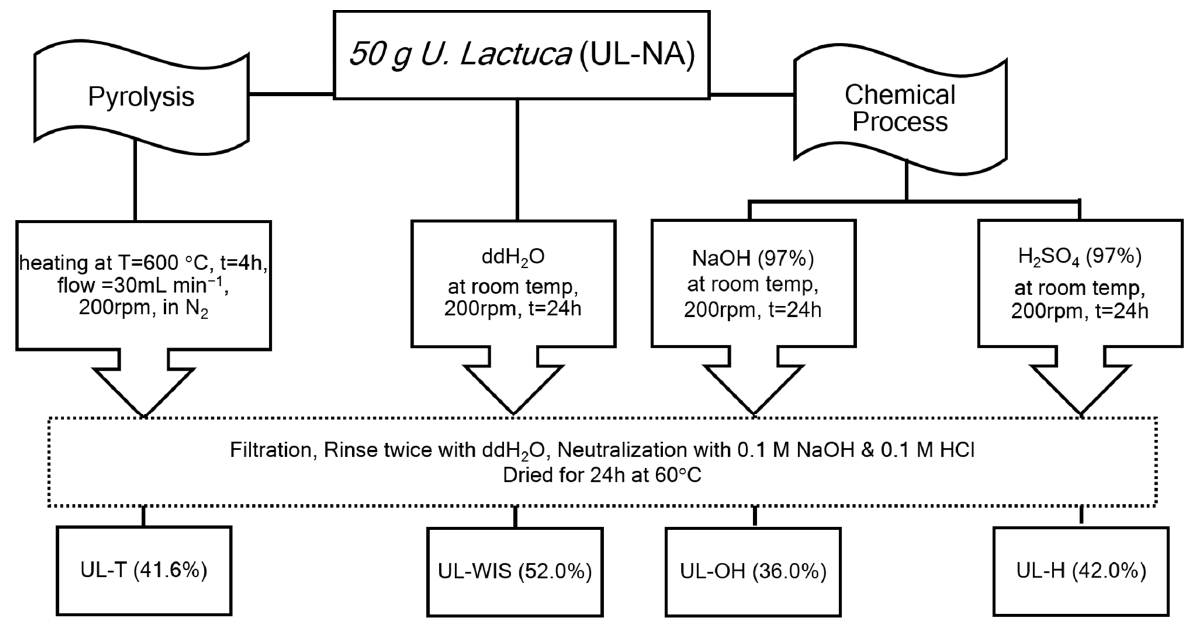
Figure 1. Methods used for activation of U. lactuca biomass chemically and using pyrolysis.